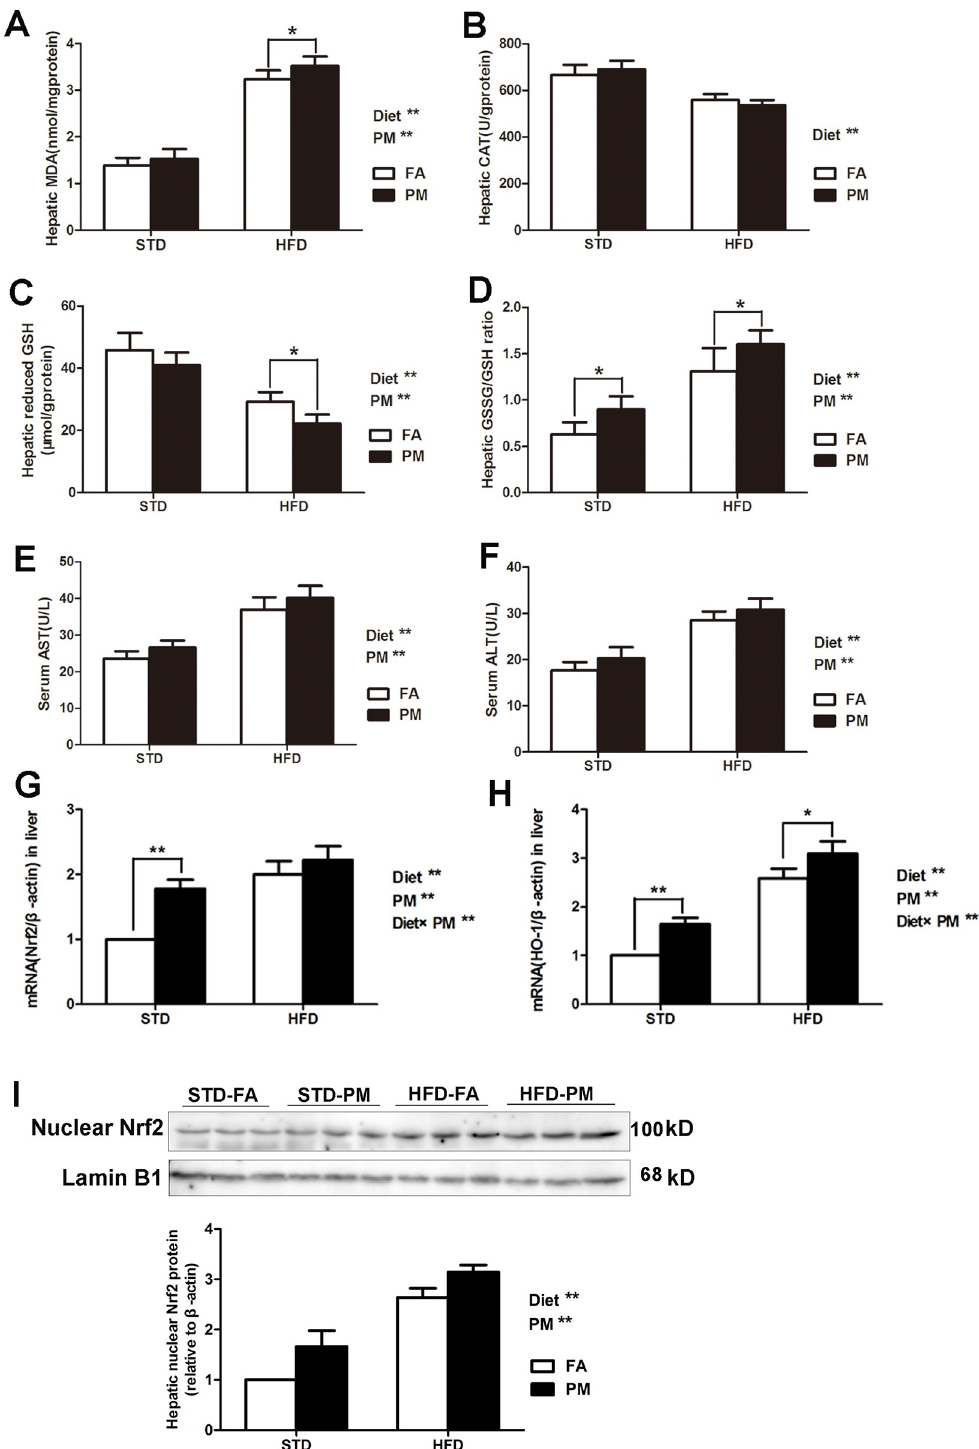
Fig 4. Ambient PM exposure induced liver injury and oxidative response in liver. (A) Hepatic MDA levels (n = 8–10). (B) Hepatic CAT levels (n = 8–10). (C) Hepatic reduced GSH levels (n = 8–10). (D) Hepatic GSSH/GSH ratio (n = 8–10). (E) Serum AST (n = 10). (F) Serum ALT (n = 10). (G) The mRNA expression of Nrf2 (n = 5). (H)The mRNA expression of HO-1(n = 5). (I) Immunoblotting of hepatic nuclear Nrf2 in four groups. (J) Immunoblotting analysis of hepatic nuclear Nrf2 in four groups (n = 3). Data are expressed as the mean ± SD. � , P < 0.05 and �� , P < 0.01.Diet �� indicates the HFD. PM �� indicates PM exposure. Diet × PM indicates the interaction effect between HFD and PM exposure. https://doi.org/10.1371/journal.pone.0214680.g004 PLOS ONE | https://doi.org/10.1371/journal.pone.0214680 March 28,